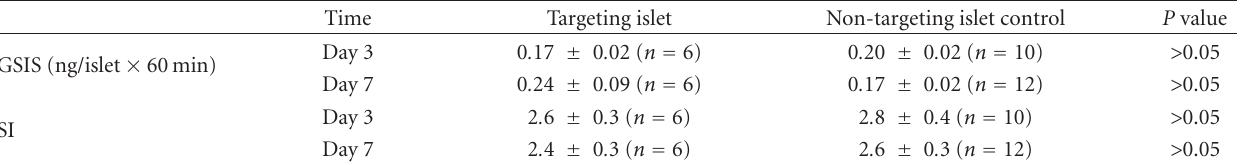
Table 2: The e ff ect of p27 kip1 silencing on islet glucose-stimulation insulin secretion in vitro . After 24h of transduction and at 3 and 7 days of culturing, batches of 30 islets per well were sequentially exposed to di ff erent concentrations of glucose. Islets were incubated in 100 mg/dL glucose for 60 min. After the medium was collected, the same batch of islets was washed and then stimulated with 360 mg/dL of glucose for 60min. The net di ff erence of insulin secretion from the glucose stimulation test (GSIS; ng/islet × 60min) was calculated as the di ff erence of the insulin content between the medium containing 360 mg/dL and medium containing 100 mg/dL glucose. The stimulation index (SI) was considered as the ratio of insulin content of the medium containing 360 mg/dL of glucose over that of the medium containing 100 mg/dL of glucose for the same batch of islets.